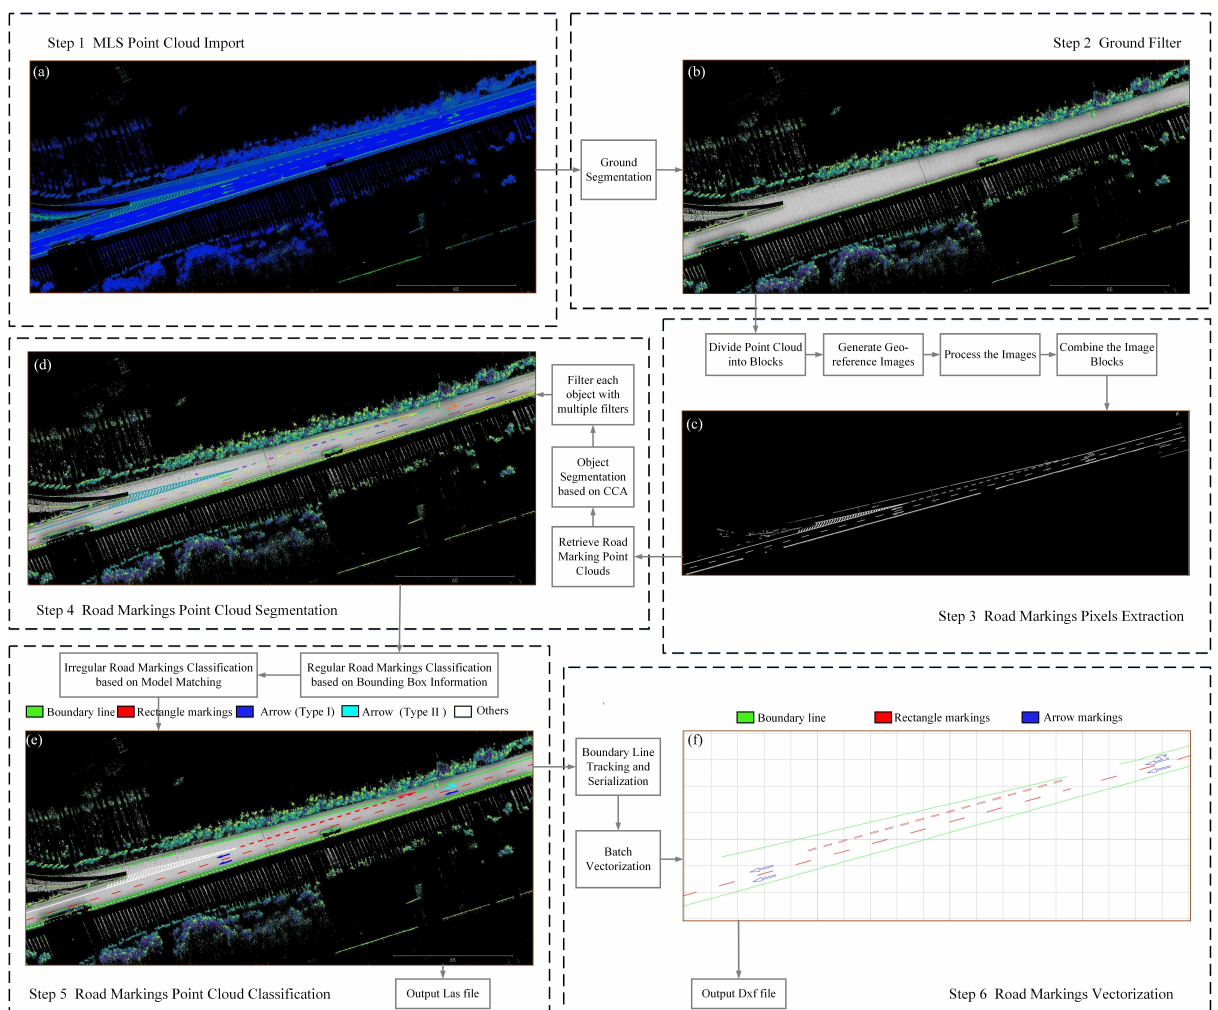
Figure 2. Workflow of the proposed method road marking boundary pixels. The procedure of georeferenced image processing is shown as